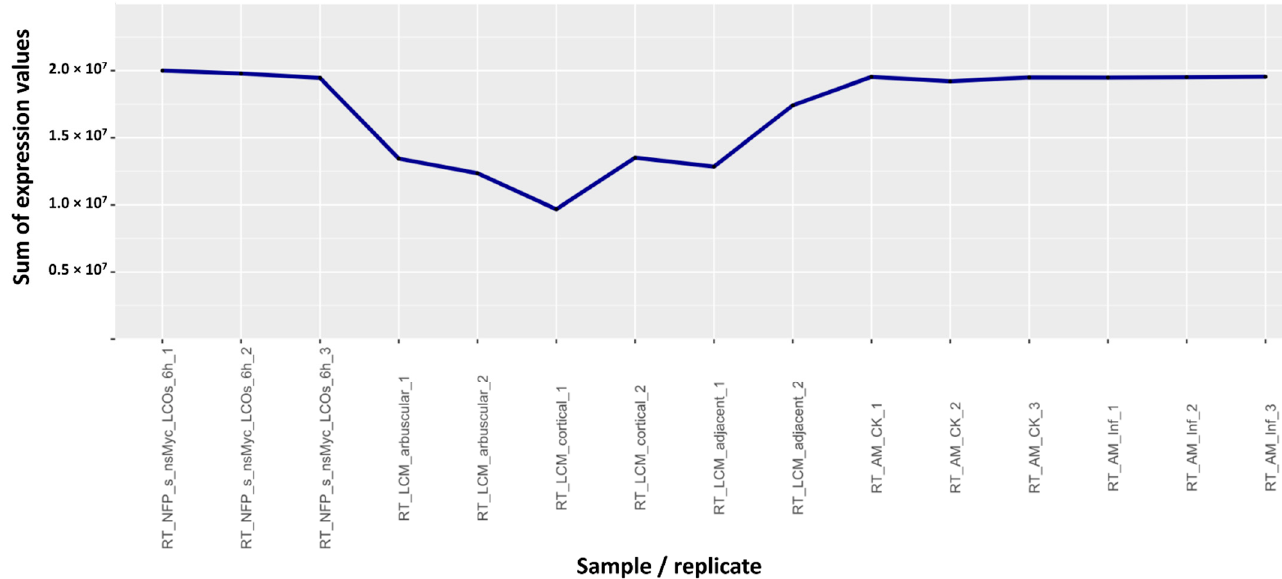
Figure 2. Graphical representation of the sum of the expression values for the RT_LCM samples [31], compared to the ones adjacent to them in the dataset list. All the other samples have sum of expression values close to 2.0 × 10 7 , whereas the RT_LCM samples range between 1.0 × 10 7 and 1.7 × 10 7 .